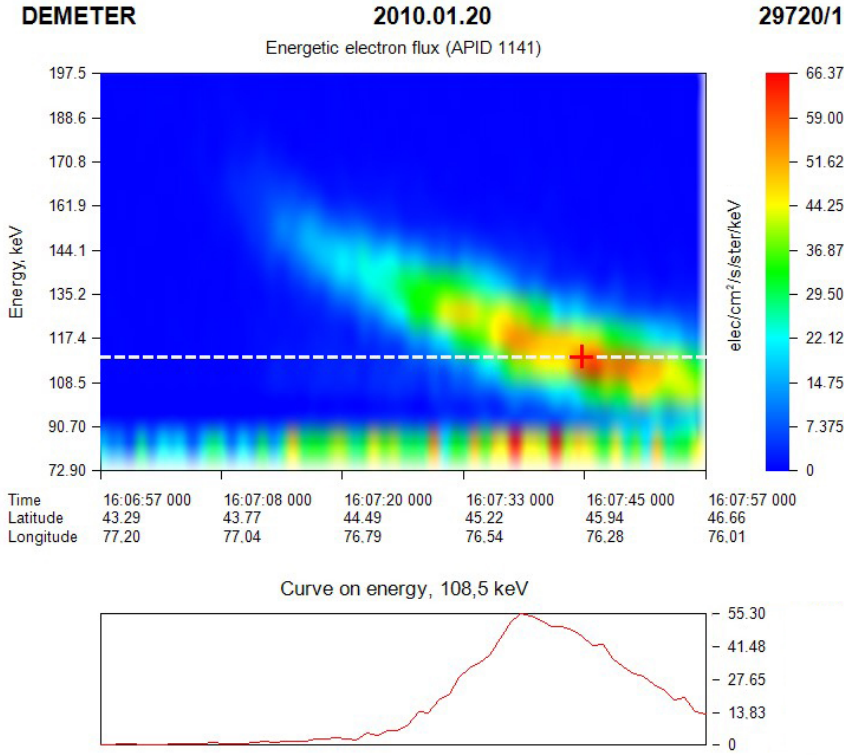
Figure 5. The energetic electrons spectrogram and graph for electrons with an energy of 108.5keV for the ascending half orbit of the DEMETER satellite no. 29720/1, 20 January